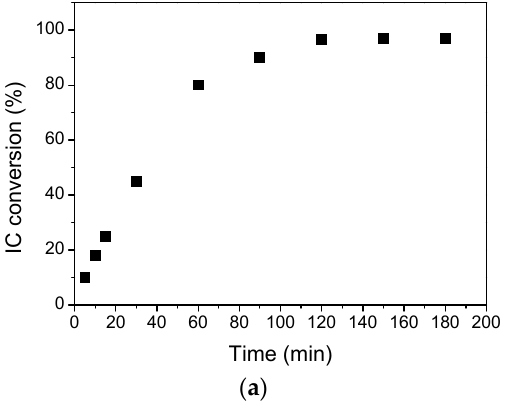
Figure 7. IC conversion on HTMo-20GO (Reaction conditions: IC 0 30 × 10 − 3 M, H 2 O 2 /IC = 48 catalysts concentration 1 wt. %, 150 rpm, 2 h, 25 °C); ( a ) Temporal variation; ( b ) UV-Vis spectra of the initial wastewater and during the process.